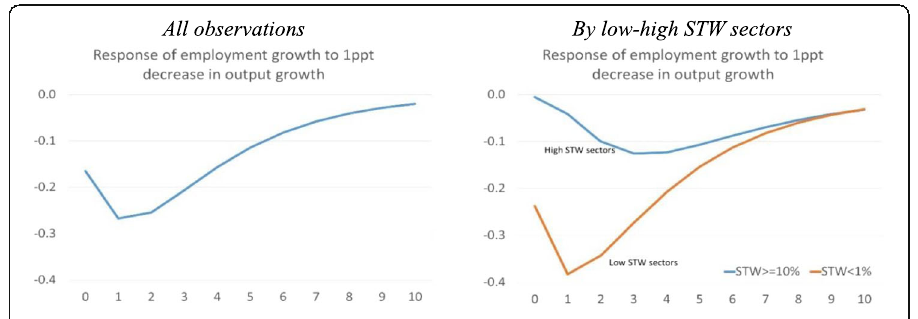
Fig. 7 Impulse response: output growth (impulse) and employment growth